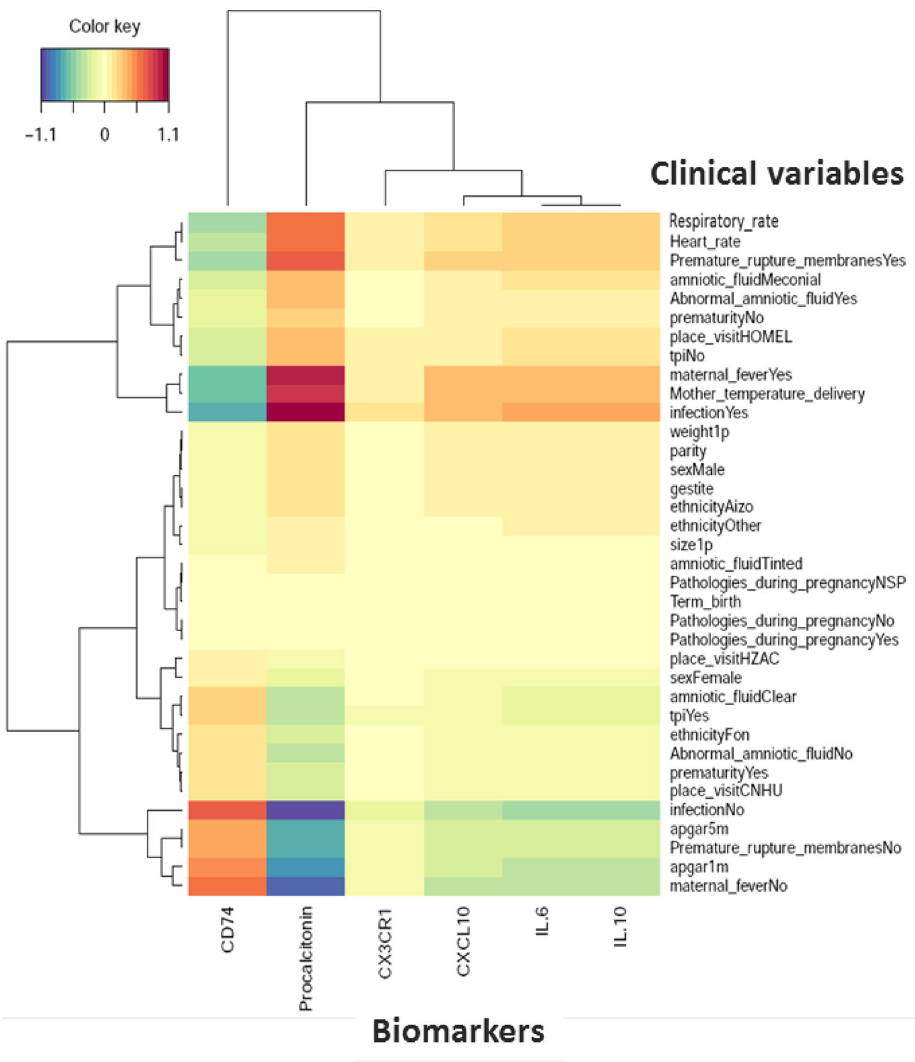
Figure 3. Biomarkers and clinical variables correlation in neonatal clinical sepsis diagnosis. Heatmap of correlation matrix (Partial Last Squares Regression) to predict biomarkers from Clinical Variables. The rows and columns correspond to clinical variables and biomarkers. Respectively positive correlations are red and negative correlations are blue. The figure shows only variables with covariances greater than max (covariance)/2 (Figure drawn using Rstudio, version2021.9.1.372, http:// wwwrs tudio. com, Boston